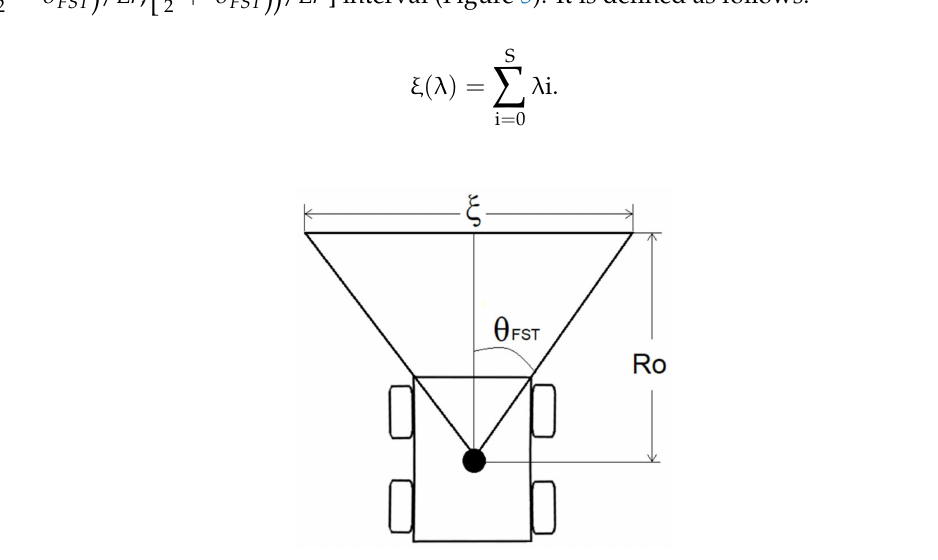
Figure 5. Free space threshold (FST)